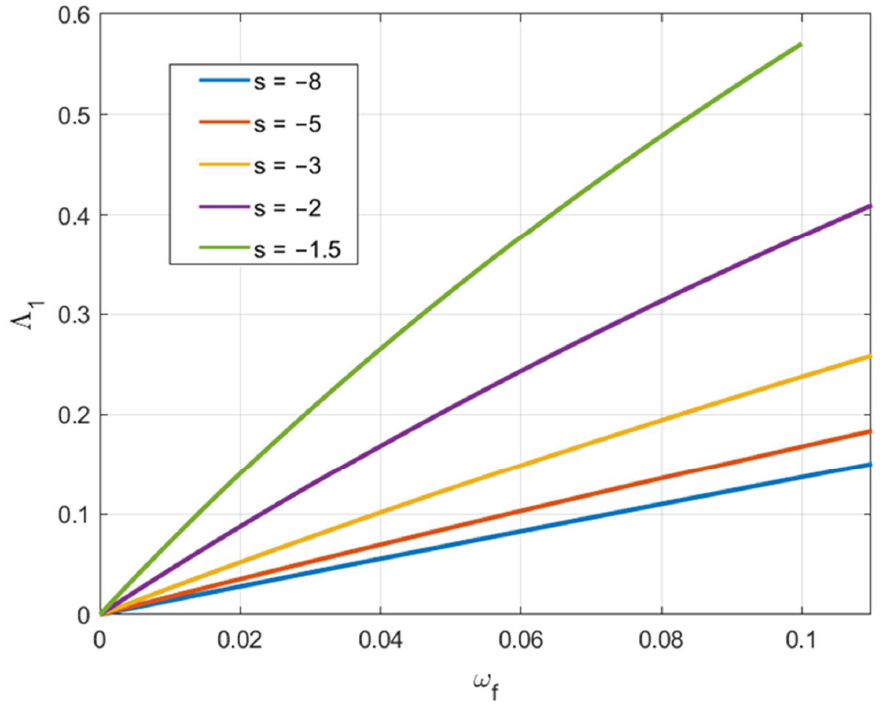
L Figure 10. Variation of 1 involved in Equation (57) with the axial feeding for several loading Figure 10. Variation of Λ 1 involved in Equation (57) with the axial feeding for several loading paths. paths.